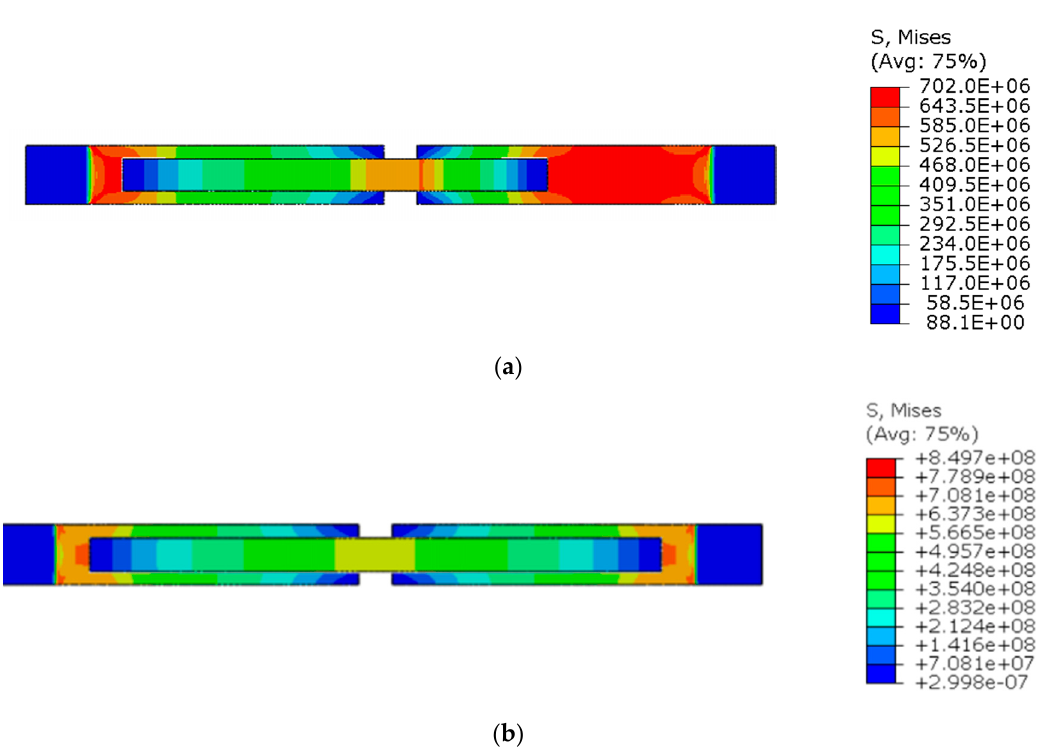
Figure 18. Tensile stresses in numerical models with overlap lengths of: ( a ) 200/400 mm; ( b ) 400/400 mm.